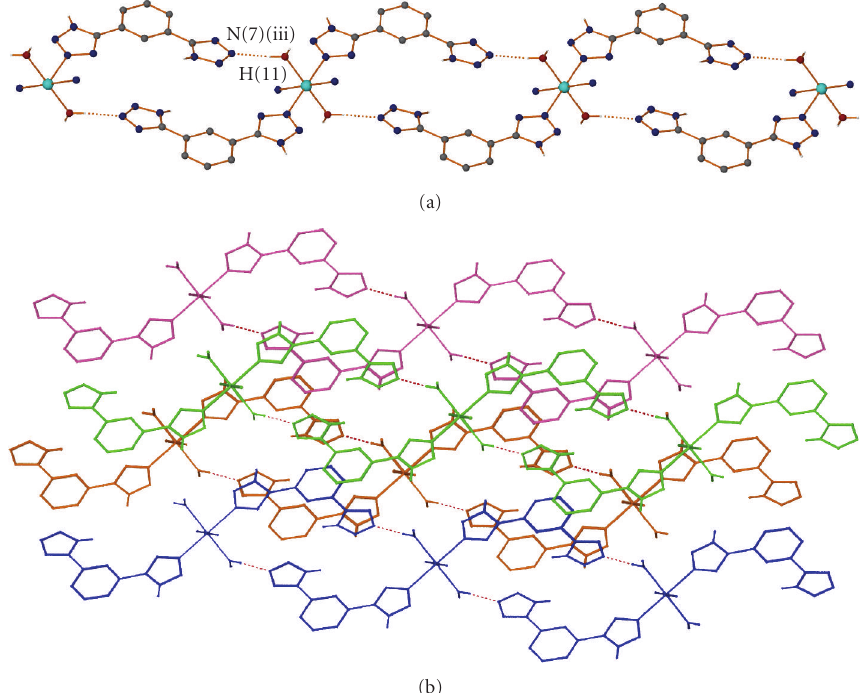
Figure 3: (a) A projection of the hydrogen bonded layer formed in 1 perpendicular to a axis; a view of 1 showing the π – π interaction. (b) The hydrogen-bonded layers are drawn in di ff erent colours to emphasize the stacking interactions between the aryl rings that lead to a 3D supramolecular architecture. Chlorine atoms, the organic hydrogen atoms, and acetonitrile carbon atoms have been omitted for clarity.